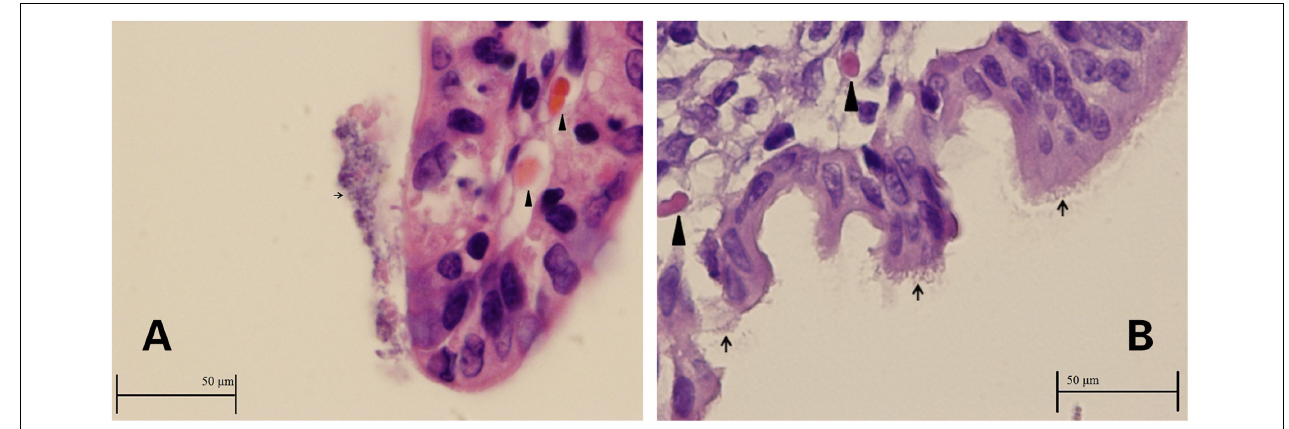
FIGURE 1 | (A,B) Images of ileum from rabbits infected with ZR1. Enterocytes and debris covered with Escherichia coli (thin arrows) and hemorrhage inside the villus (thick arrowheads).